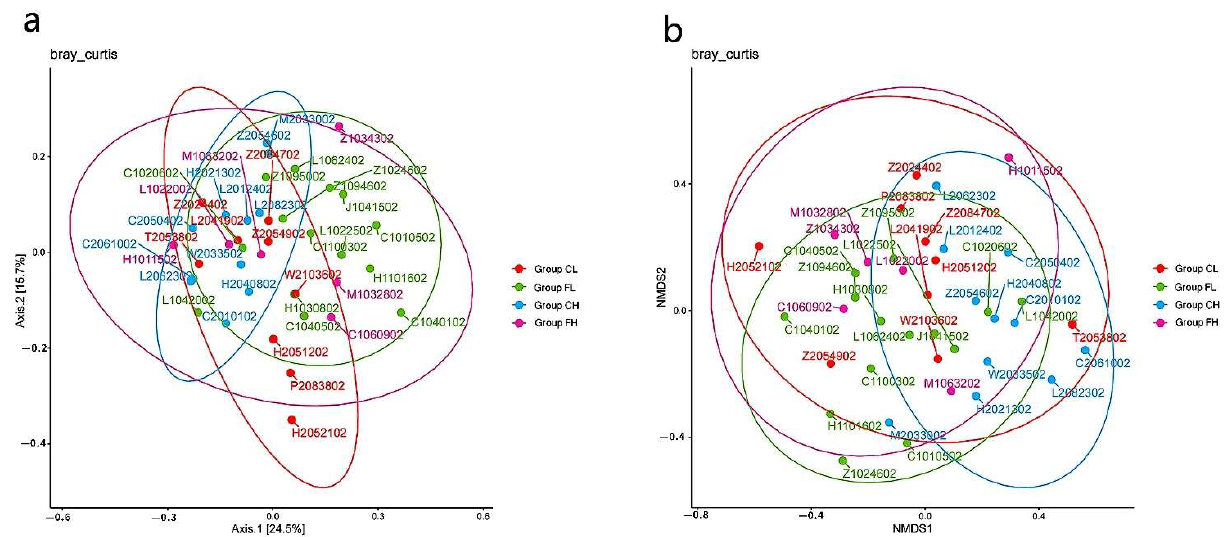
Figure 4. Diversity analysis between groups: ( a ) PCoA and ( b ) nonmetric multidimensional analysis based on Bray–Curtis distances.